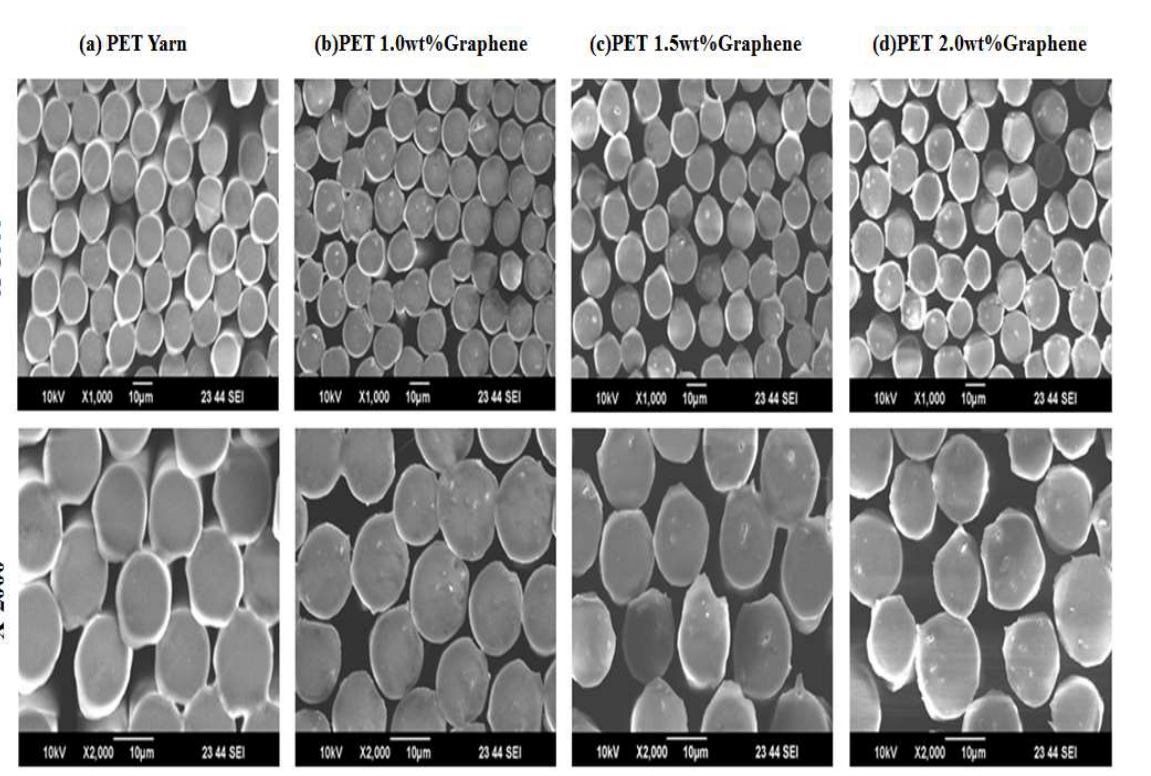
Figure 6. Fiber cross-section observation ( a ) conventional polyester yarn, ( b ) 1.0 wt% nanogra- phene powder, ( c ) 1.5 wt% nanographene powder, ( d ) 2.0 wt% nanographene